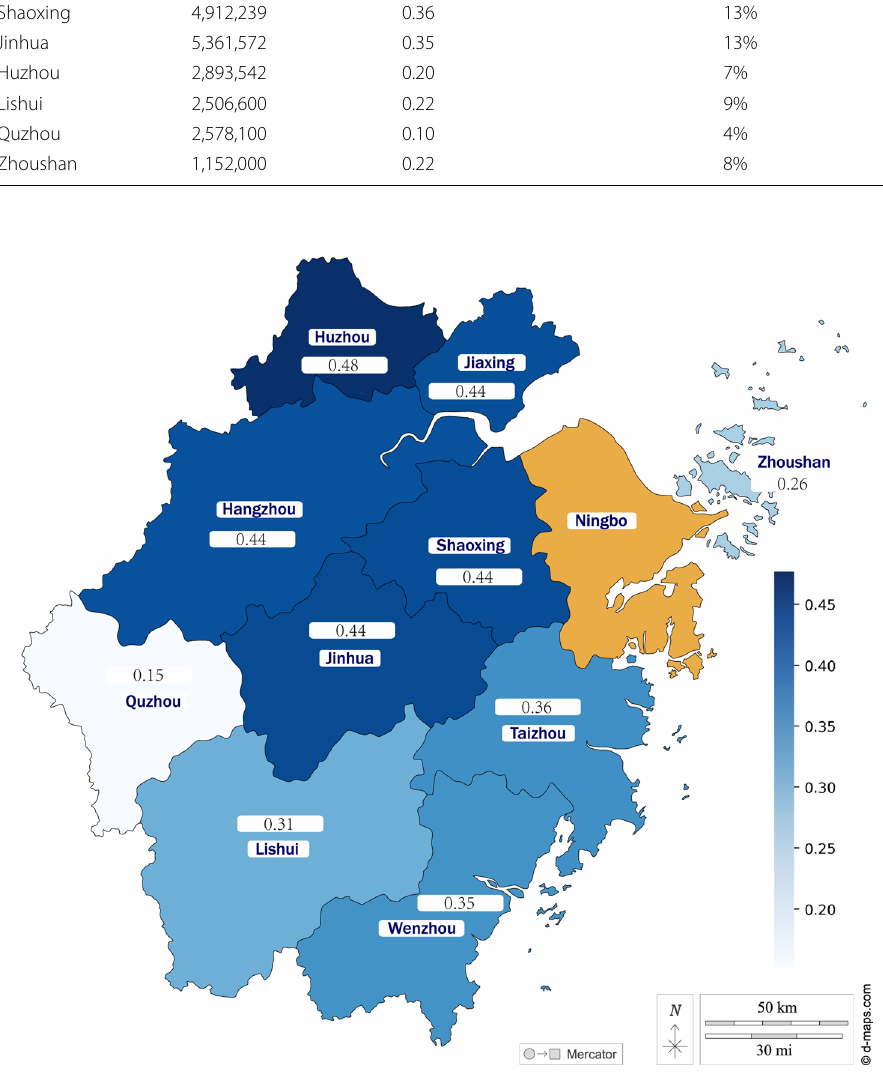
Fig. 4 The correlation between Zhejiang cities’ mobility ratio and Ningbo’s COVID-19 cases [For example, the correlation score between Hangzhou’s mobility to Ningbo and Ningbo’s COVID-19 cases is